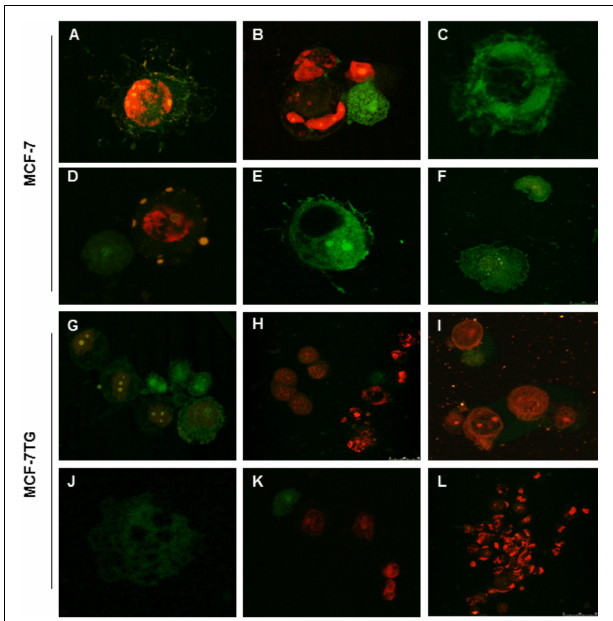
FIGURE 5 | Confocal analysis of MCF-7 (A) and MCF-7TG (G) cells mock-treated and treated with bozepinib (B,C,H,I) , FC-26c (D,J) , FC-29b (E,K) , and FC-30b2 (F,L) . Cells were stained with annexin V-FITC and PI as described in the section “Materials and Methods.” Early apoptosis (stained positive for annexin V-FITC and negative for PI), late apoptosis or cell death (stained positive for both annexin V-FITC and PI) and necrosis (stained positive for PI) can be observed; viable cells are not visible. In MCF-7 treated cells we observe cells characteristic of late (A,B,D) and early apoptosis (C,E,F) . MCF-7TG cells treated with different drugs showed some early and late apoptotic cells (G,H,J–L) but much more necrotic cells (H,I,K,L)